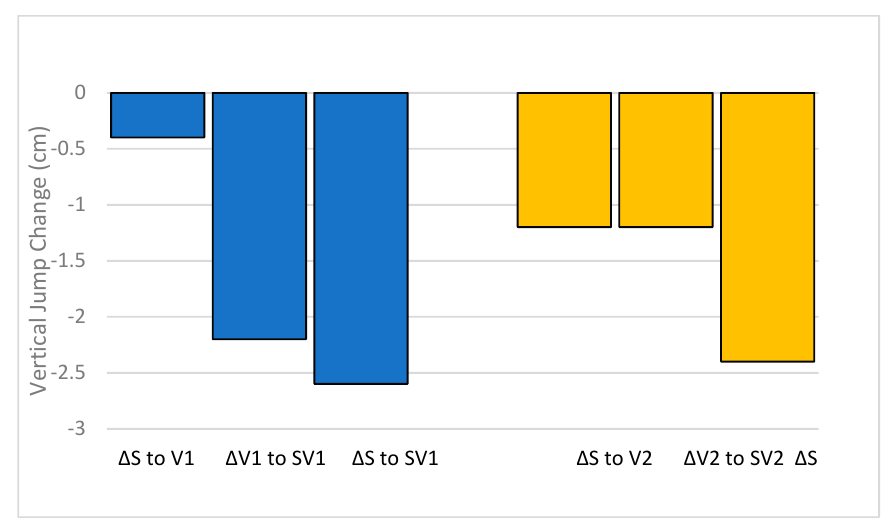
Figure 6. Change in vertical jump scores from baseline (station wear = 0 cm).